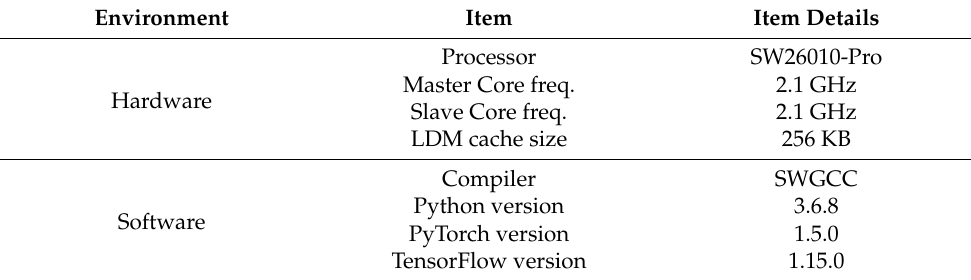
Table 4. Experimental setup.